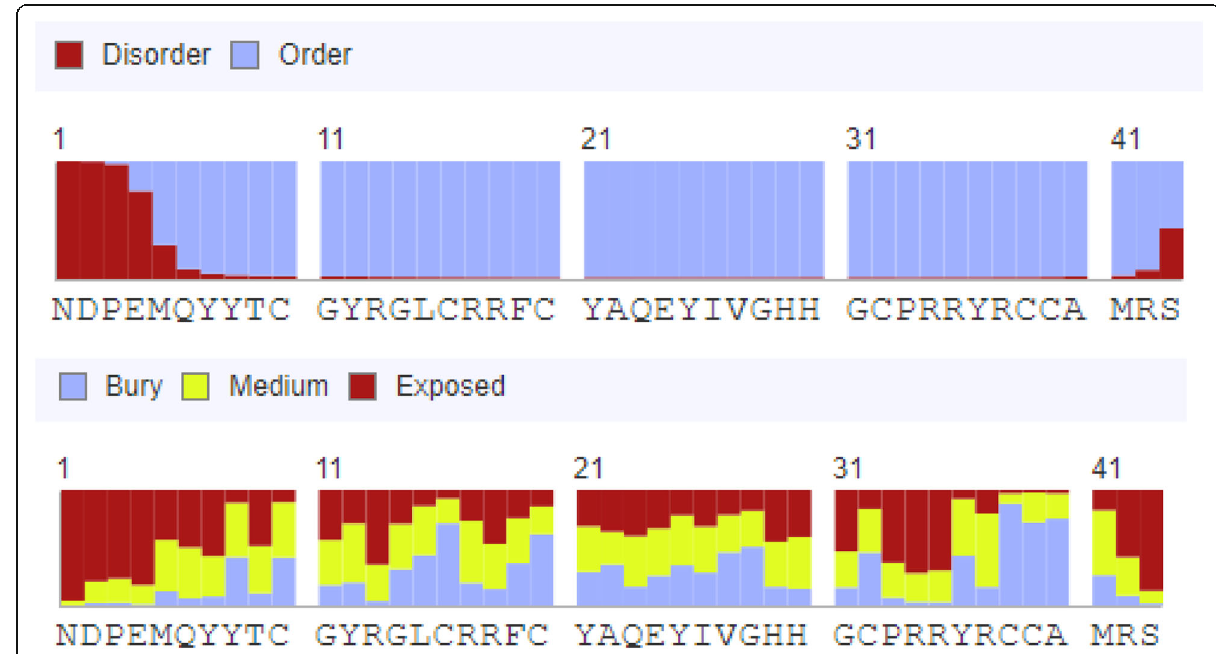
Fig. 5 RaptorX forecasted N-terminal region of the On -Def mature peptide as disordered. Most of the molecule was seen exposed showing surface accessibility